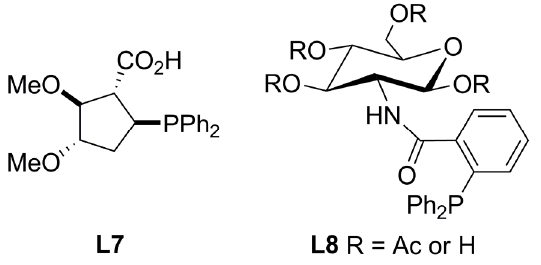
Figure 2. Monophosphines with central chirality on carbon atoms.